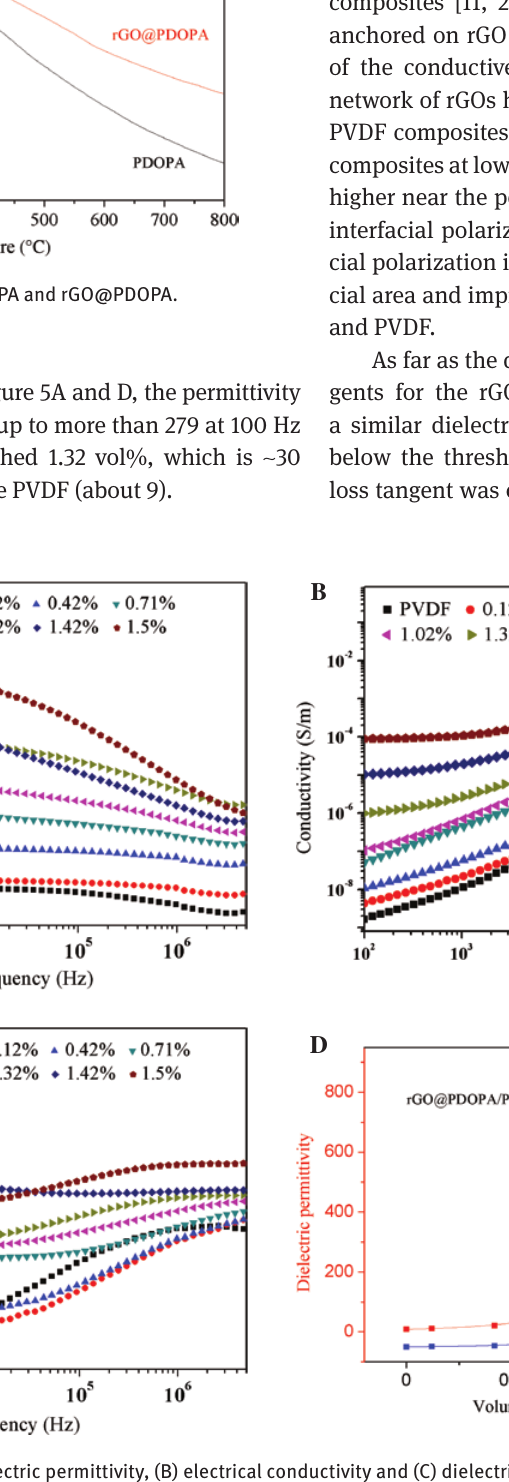
Figure 5: Dependence of (A) dielectric permittivity, (B) electrical conductivity and (C) dielectric loss on the frequency for rGO@PDOPA/PVDF composites. (D) Dielectric permittivity and dielectric loss of rGO@PDOPA/PVDF as a function of volume fraction of rGO at 1000